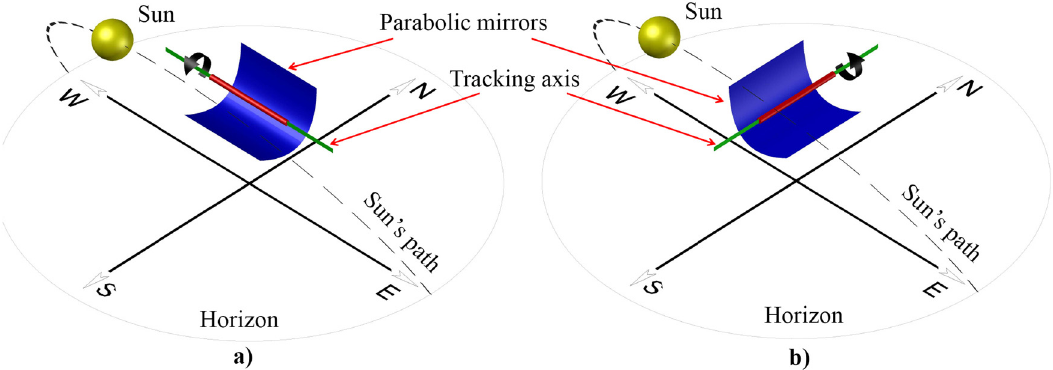
Figure 3: Common tracking methods: ( a ) north - south, ( b ) east -